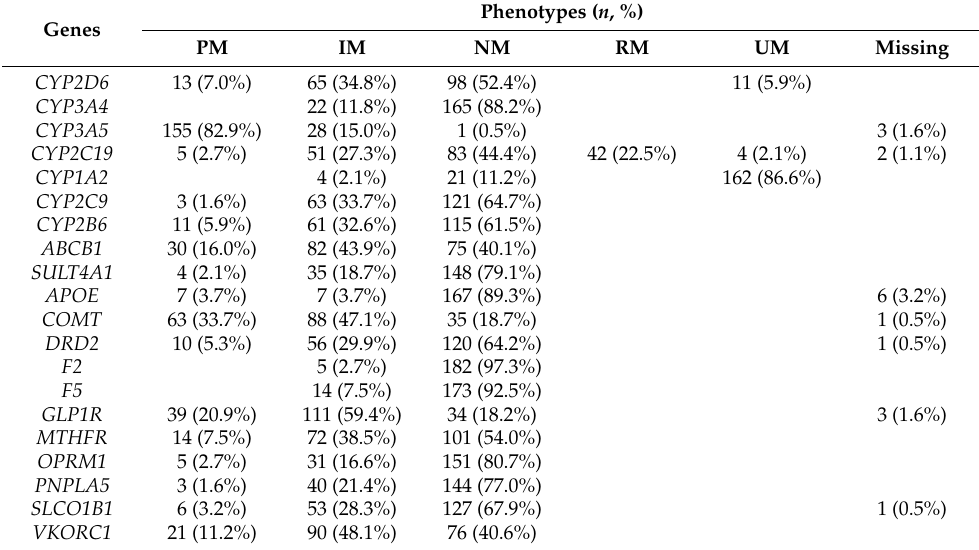
Table 2. Genetically-defined Metabolic Activity